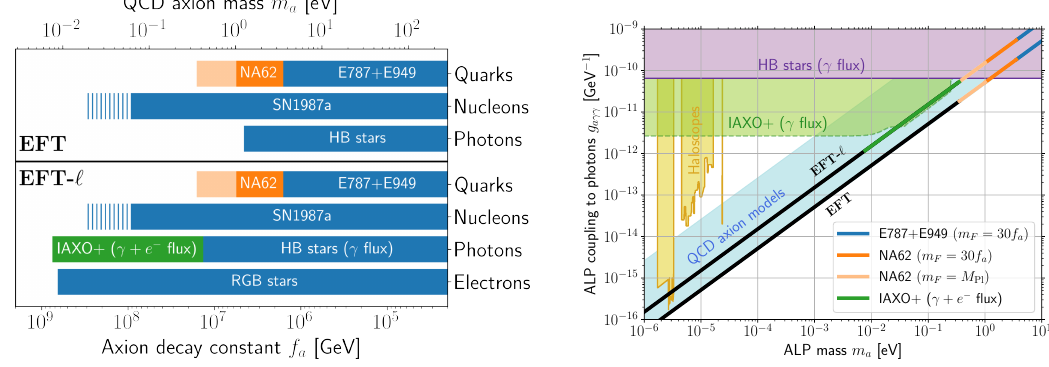
Figure 4 . Constraints on the two variations of the model introduced in section 4, which we denote EFT- ‘ and EFT depending on whether tree-level axion-lepton couplings are present or not. On the left, we present the bounds as a function of the QCD axion decay constant. For the K + → π + + a constraints, the lighter shading of orange represents the range of possible values of the cutoff scale for the leading log, Λ ∈ (30 f a , M Pl ) as discussed in the main text. The vertical hatching indicates uncertainties in the supernova limit. On the right, we show the models predictions in the usual mass vs. photon coupling parameter space. The band of QCD axion models corresponds to E/N ∈ (44 / 3 , 5 / 3) as defined in [132]. Note that IAXO becomes particularly sensitive to the EFT- ‘ model due to solar axion production through axion-electron interactions. Hence, the predicted IAXO sensitivity in dark green is based on the interactions with both electrons and